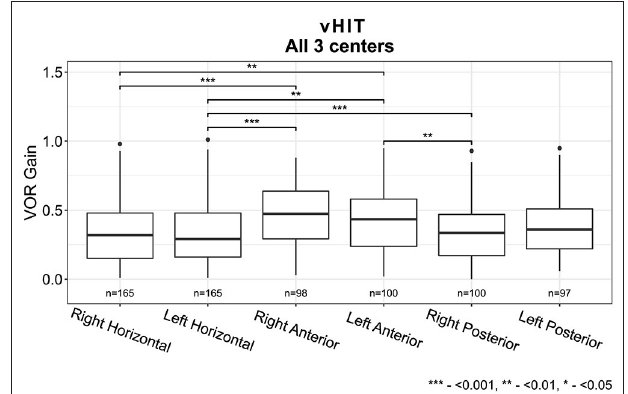
FIGURE 3 | Vestibulo-ocular reflex (VOR) gain for all six semi-circular canals measured with video Head Impulse Test for all three centers combined (Horizontal canals: center 1, 2 and 3, Vertical canals: center 1 and 2). Each box plot represents the 25 to 75 percentiles, bold black lines the median, dots the outliers, and asterisks (*) illustrate statistically significant differences.